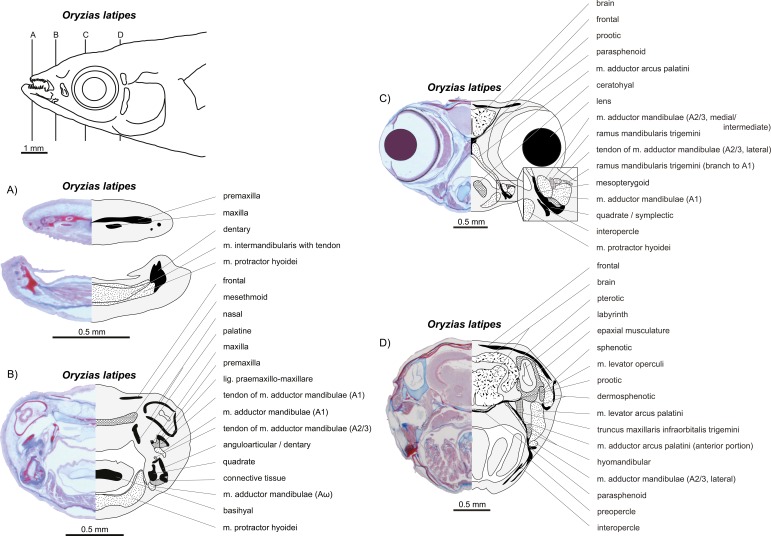
Oryzias latipes.(A–D) Histological sections; compare to Fig. 12. Modified from Werneburg & Hertwig (2009).